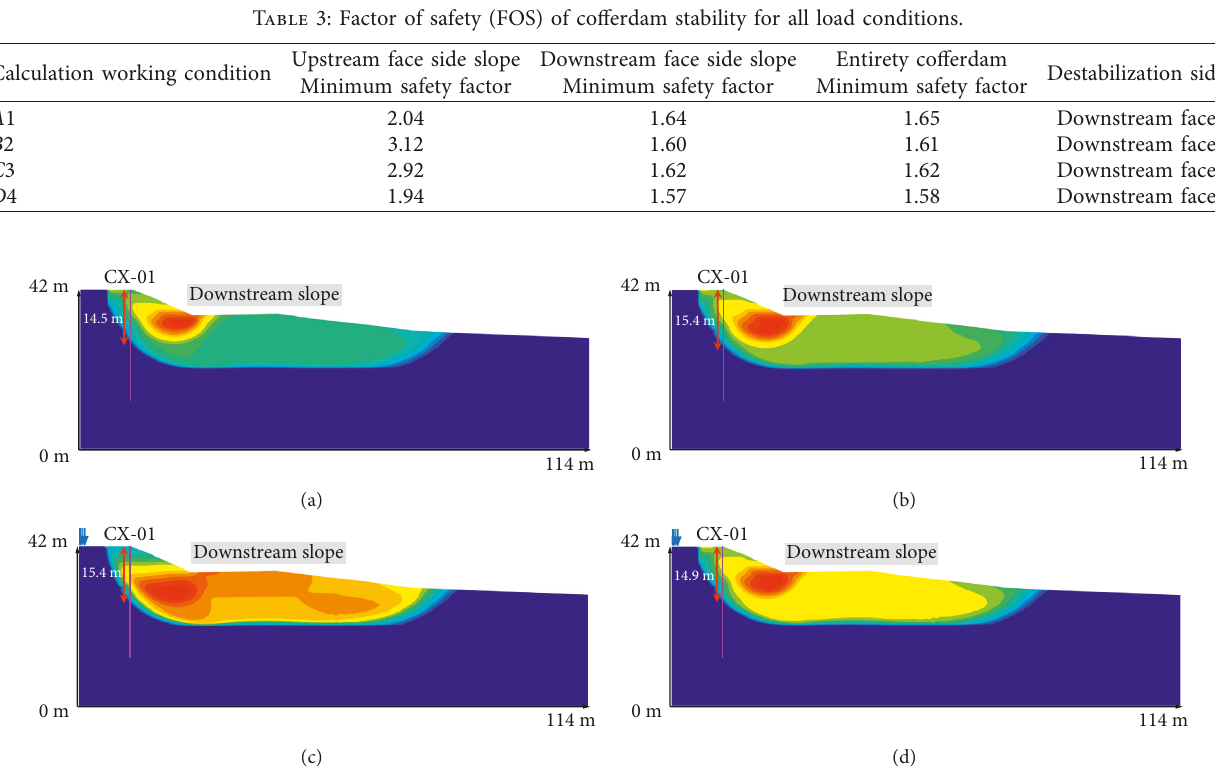
Figure 9: Horizontal displacement clouds of the backwater slope hazardous slip surface: (a) working condition A 1; (b) working condition B 2; (c) working condition C 3; (d) working condition D